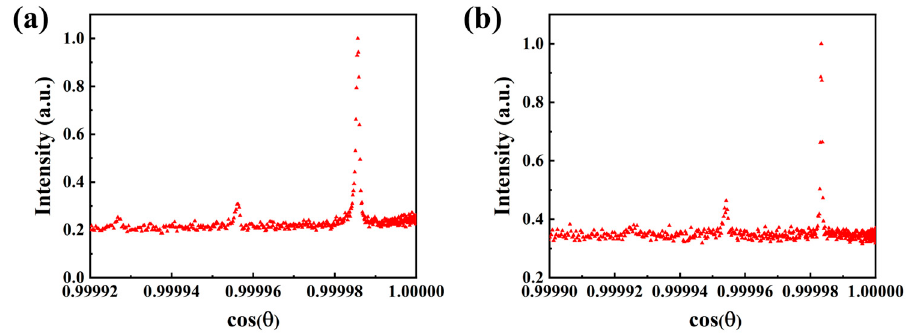
Figure 3. ( a ) Scatter plot after linear processing of the abscissa in Figure 2 (R = 95%) and ( b ) scatter plot after linear processing of the abscissa in Figure 2 (R = 99.5%).